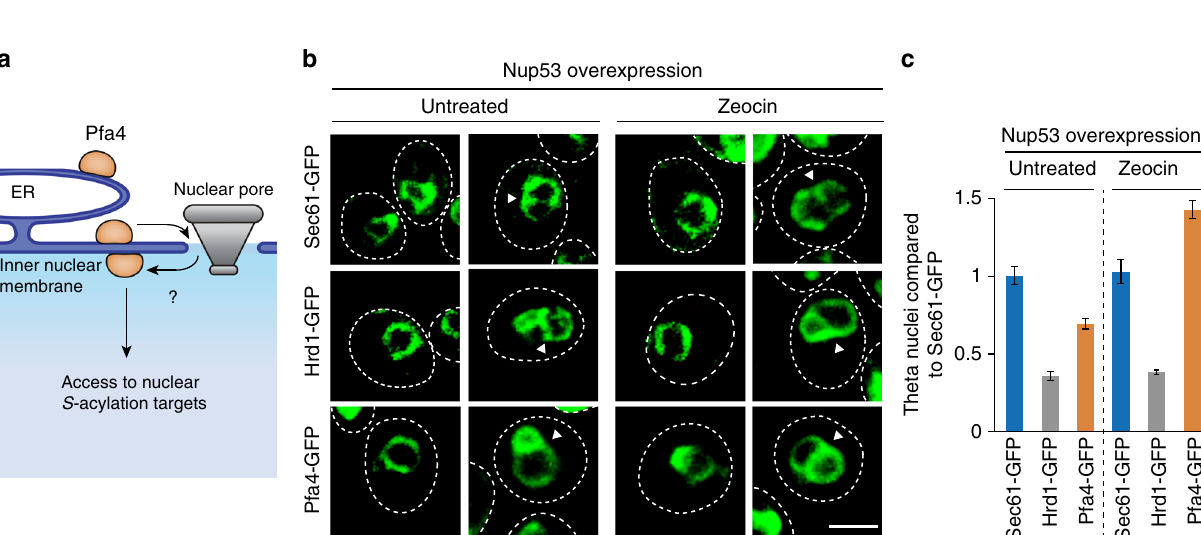
Fig. 4 S -acylation of Rif1 C466 and C473 in vivo. a Outline of the ABE protocol, including protein alkylation at free cysteines with NEM, removal of S -acyl groups including palmitoyl (Palm) using hydroxylamine (HA), and labeling with BMCC-biotin. Biotinylated proteins are captured on NeutrAvidin-coated beads and the presence of Rif1 NTD is analyzed by western blotting (WB). b Representative western blots of ABE assays performed with cells expressing Myc-tagged Rif1 NTD under control of a GAL1 promoter. Input: BMCC-biotin samples prior to biotin capture with and without HA. Input and AviF samples were probed with anti-Myc and anti-biotin antibodies as indicated. Fold enrichment of Rif1 NTD in AviF relative to wild-type is presented as mean values ± s.e.m. ( n = 3 independent experiments). c Outline of the ACE protocol, including treatment of proteins with TCEP (reducing potential disul fi de bridges between cysteine residues), alkylation at free cysteines with NEM, removal of S -acyl groups using DTT, and alkylation of freed-up cysteines with chloroacetamide. Myc-tagged Rif1 NTD is then immunoprecipitated for analysis by mass spectrometry (see Supplementary Fig. 4a for additional controls). d Mass-spectrometric analysis of tryptic Rif1 fragments spanning amino acids 463 to 479. Following ACE, Rif1 NTD tryptic peptides were subjected to parallel reaction monitoring (PRM), measuring NEM (unmodi fi ed Rif1) and/or CAM-labeled (re fl ecting in vivo S- acylation) C466 and C473 in wild-type vs. pfa4 Δ . Integrated PRM counts are presented as mean values ± s.e.m. and were normalized using measurements of the fi ve non-modi fi ed Rif1 peptides shown on the right (see Supplementary Table 1 for additional information). Data are shown in logarithmic scale ( n = 3 independent experiments). e Measurements of C466/C473 NEM and/or CAM-labeled peptides (left panel) and unmodi fi ed control peptides (right panel) of Rif1 in untreated vs. Zeocin- treated wild-type cells. PRM analysis of Rif1 NTD peptides as in panel d . Mean values of integrated PRM counts ± s.e.m ( n = 3 independent experiments) are shown in logarithmic scale. See Supplementary Fig. 4b, c for peptide transitions used in the experiment. Source data are provided as a Source Data fi le